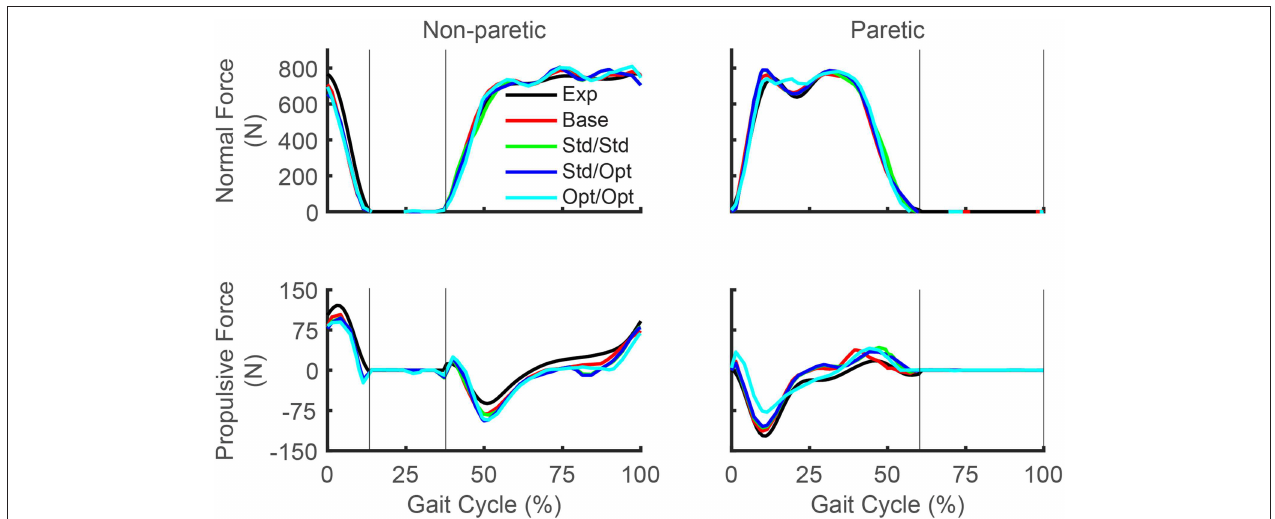
FIGURE 4 | Experimental and predicted ground reaction forces over the gait cycle. Normal ground reaction force (top row) and propulsive ground reaction force (bottom row) are presented for the non-paretic leg (left column) and the paretic leg (right column). Thin vertical lines indicate locations of heel strike and toe off. Exp indicates experimental curves, Base indicates curves from the baseline treatment optimization with no muscle stimulation, Std/Std indicates curves from the FastFES treatment optimization using standard muscle selection with standard stimulation timing, Std/Opt indicates curves from the FastFES treatment optimization using standard muscle selection with optimized stimulation timing, and Opt/Opt indicates curves from the FastFES treatment optimization using optimized muscle selection with optimized stimulation timing. Note that the non-paretic leg is the left leg while the paretic leg is the right leg.